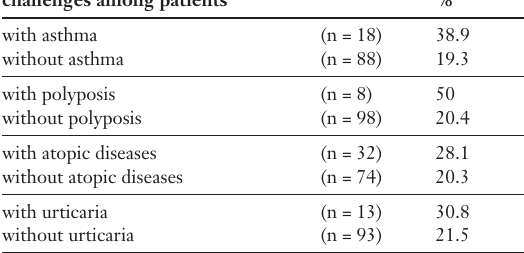
Table 4 Frequency of adverse reactions during oral challenges in defined subgroups of